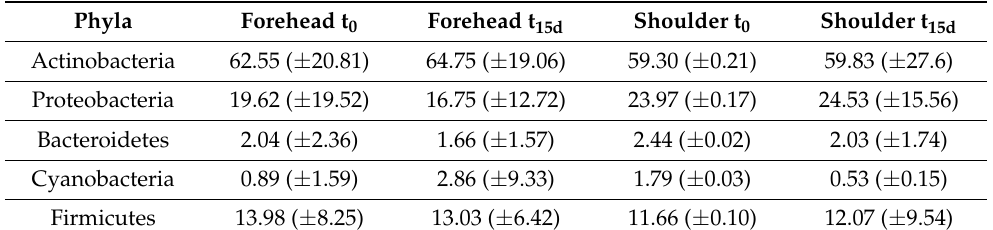
Table 6. Microbiota analyses results expressed as % distribution at phylum level over time both on forehead and on shoulder areas.